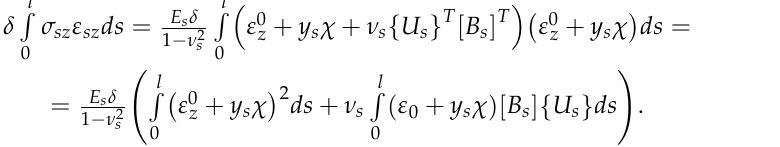
—stiffness matrix of the steel